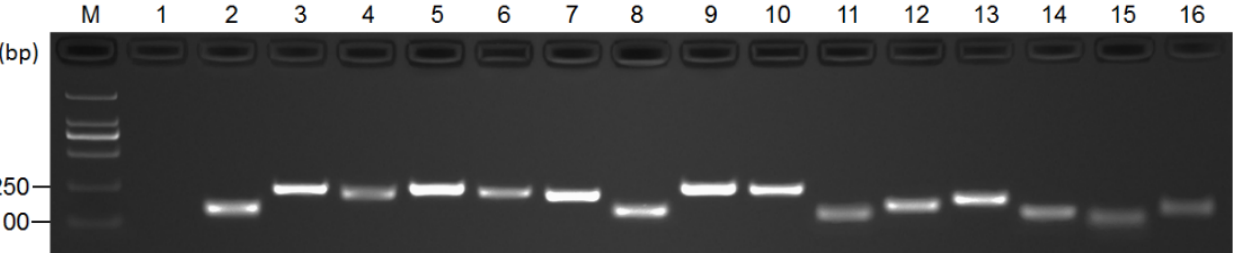
Figure 1. Specificity of primer pairs for RT-qPCR amplification of twelve candidate reference genes and three target genes. The 2% agarose gel electrophoresis shows the expected size of a single band of each candidate reference gene and target gene. M: 2K DNA marker; Lane 1: no-template control; Lane 2 to Lane 16: TBP1 , ACT7 , CBP20 , EF-1 α , EIF4A1 , GAPA , GAPB , PTB1 , TIP41 , ACT1 , eIF2 , TUB1 , ACO1 , PYL1 and CSD2 .